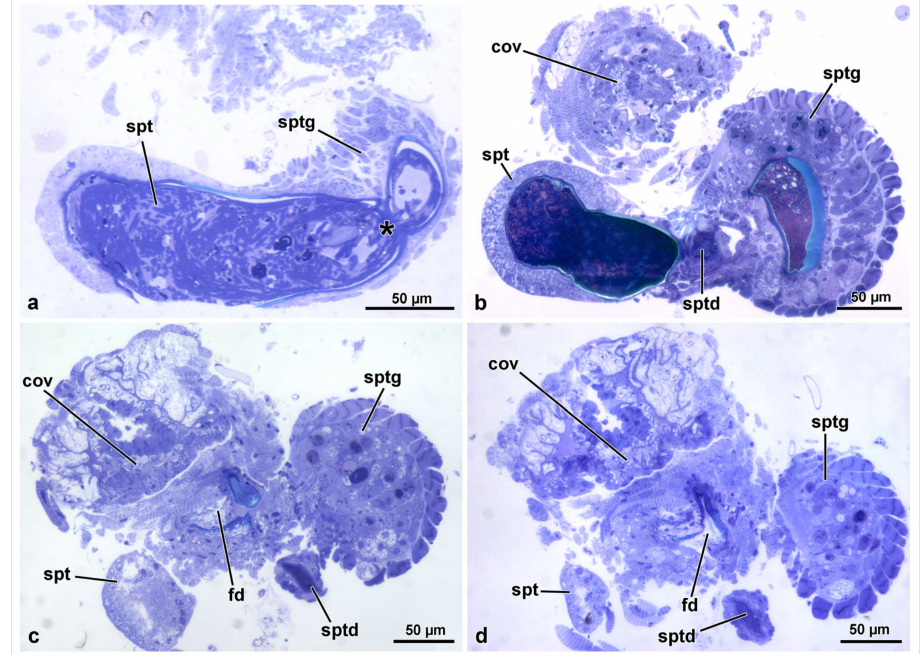
Figure 2. ( a ). Semi-thin section of the spermatheca (spt) and the narrow connection (asterisk) to the spermathecal gland (sptg). Note the thin wall of the spermatheca compared to that of the spermathecal gland. ( b ). Semi-thin section of the complex spermatheca (spt)–spermathecal gland (sptg). Note the quite evident different thickness of the wall of the two districts. Note also the opening the spermathecal duct (sptd). cov, common oviduct. ( c , d ). Consecutive semi-thin sections showing the position of the fertilization duct (fd) beneath the complex spermatheca (spt)–spermathecal gland (sptg). cov, common oviduct; sptd, spermathecal